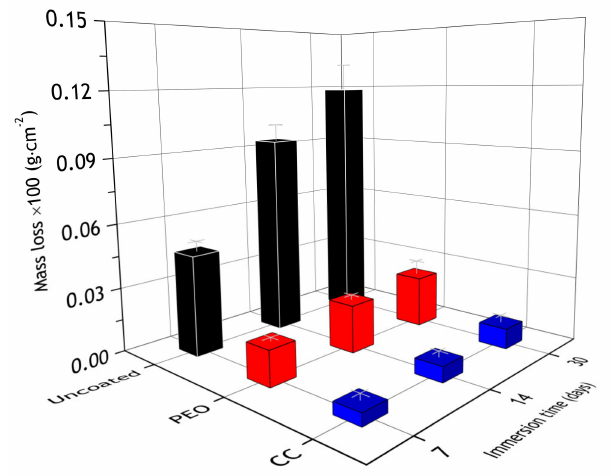
Figure 20. Mass loss of bare alloy, PEO and composite coated samples after 7, 14 and 30 days of marine immersion.